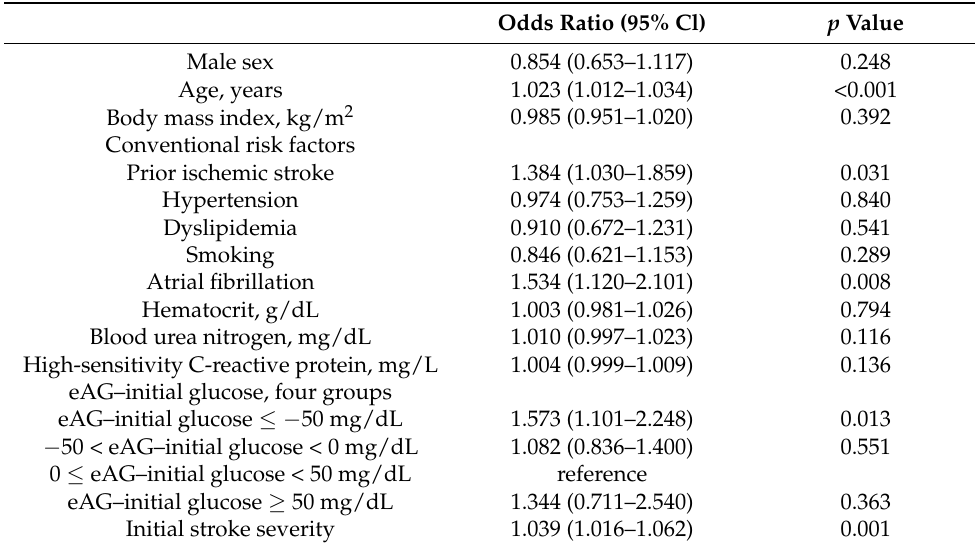
Table 3. Binary logistic-regression analysis for poor short-term functional outcomes, mRS 2–6, 3 months after stroke (compared to mRS 0–1, 3 months after